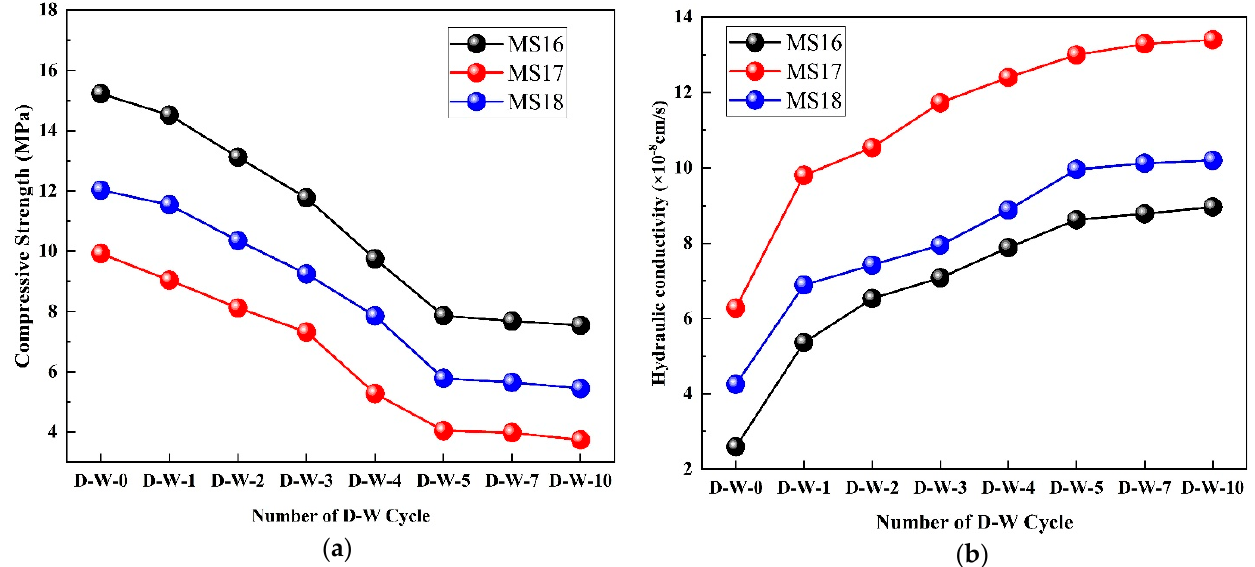
Figure 7. Compressive strength and hydraulic conductivity of MS16–MS18 samples during drying– wetting cycles. ( a ) Compressive strength; ( b ) Hydraulic conductivity. wetting cycles. ( a ) Compressive strength; ( b ) Hydraulic